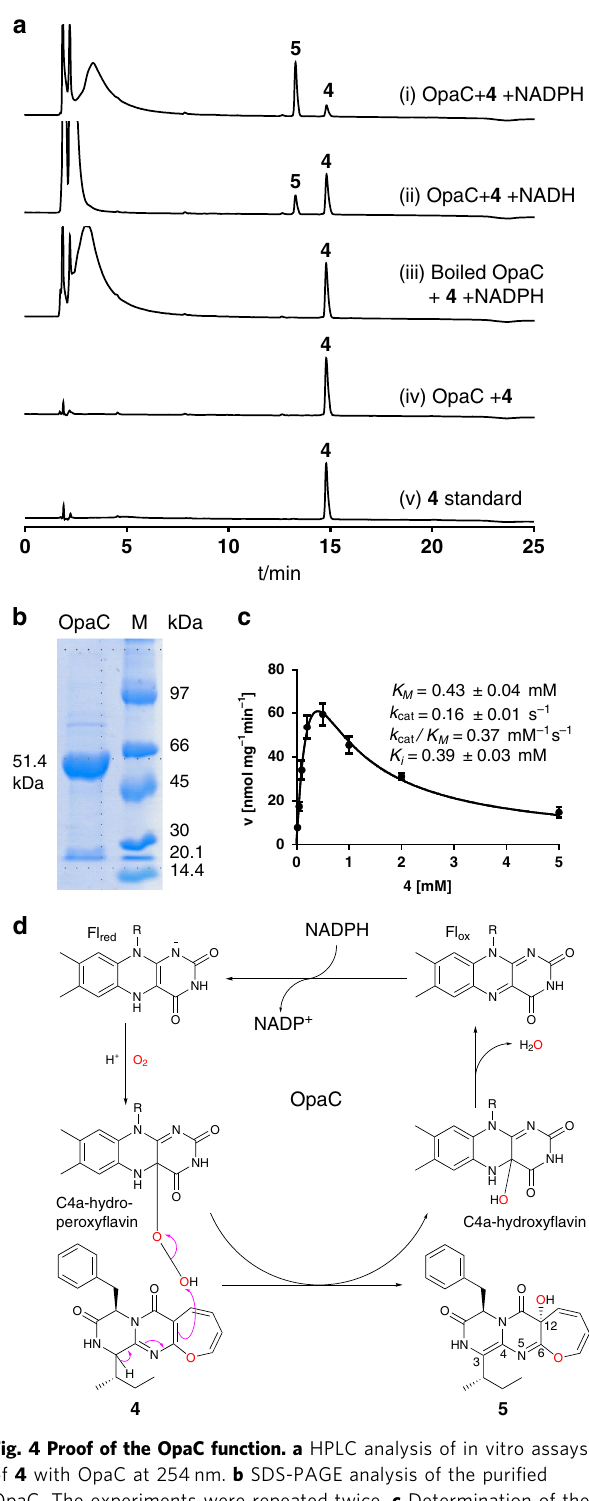
Fig. 4 Proof of the OpaC function. a HPLC analysis of in vitro assays of 4 with OpaC at 254 nm. b SDS-PAGE analysis of the puri fi ed OpaC. The experiments were repeated twice. c Determination of the kinetic parameters of the OpaC reaction. The error bars represent standard errors of velocity and the standard errors of mean (SEMs) are given as ±values ( n = six independent experiments). d Proposed mechanism for the OpaC reaction with a C4a-peroxy fl avin as a key